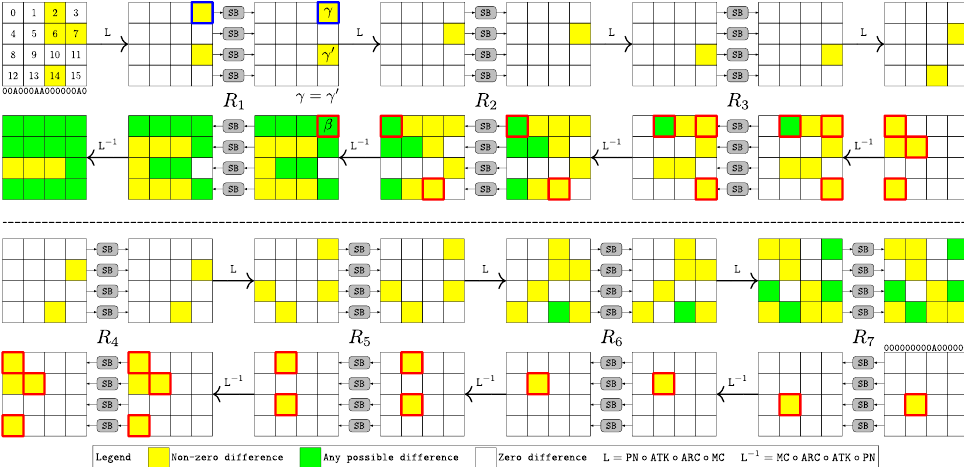
Figure 17: A 7-round boomerang distinguisher for CRAFT